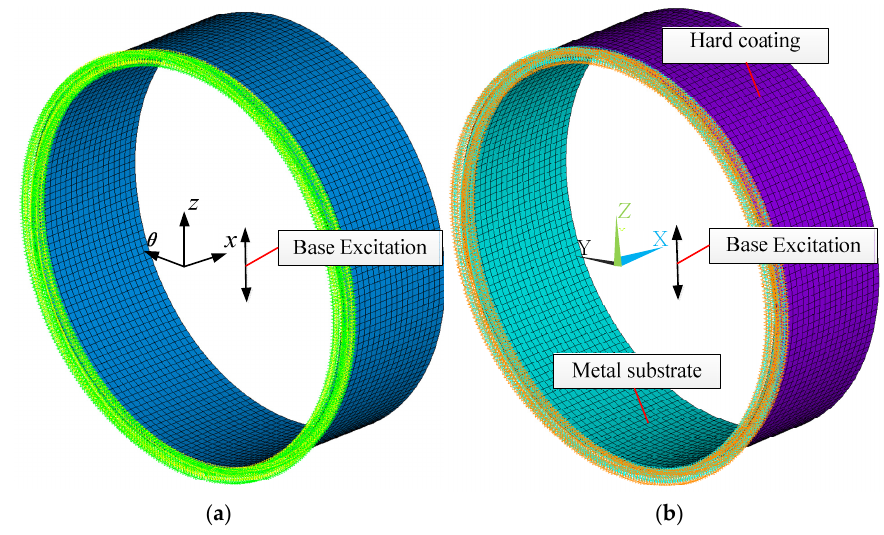
Figure 4. Two finite element models of the hard ‐ coating cylindrical shell: ( a ) Present model; ( b ) FEIM model.